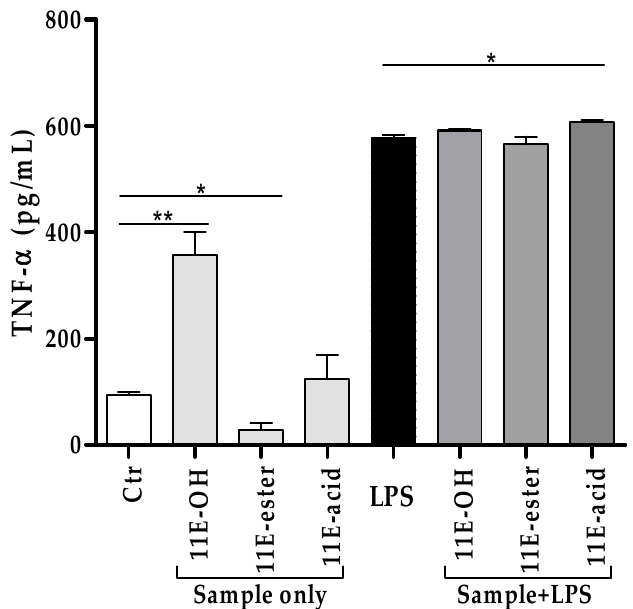
Figure 3. Effect of eicosenoid compounds on the production of TNF- α by PMA-differentiated THP-1 cells in the absence and presence of LPS (0.5 µ g / mL). The TNF- α levels were significantly increased by 11E-acid when compared with LPS alone ( n = 3). Ctr: Untreated control; LPS: Lipopolysaccharide; (11E-OH): (Z)-11-eicosenol; (11E-ester): Eicosenoate; (11E-acid): Eicosenoic acid; *: Significant ( p < 0.05); **: Significant ( p < 0.01).